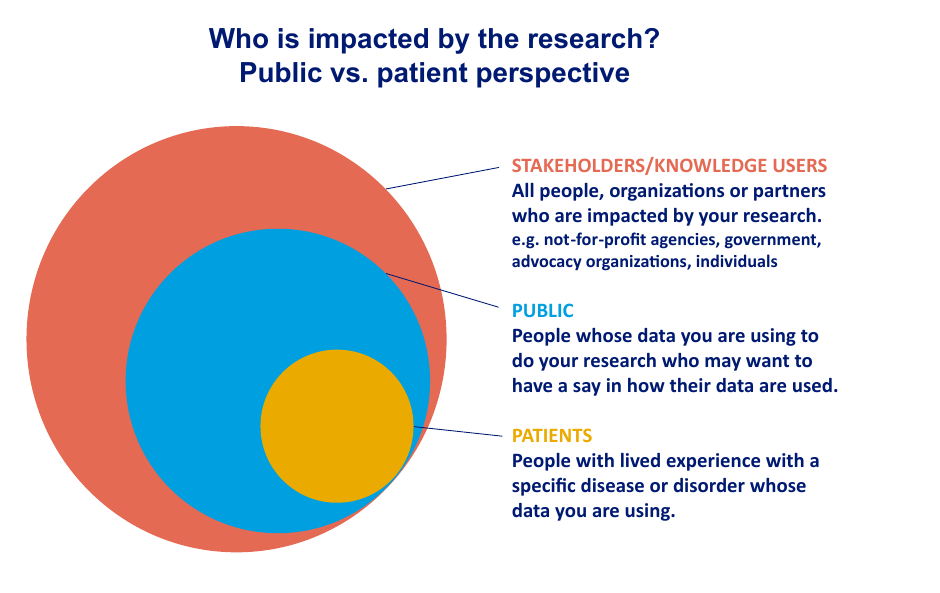
Figure 3: Levels of perspective, describing ICES’ approach to defining the difference between stakeholder, public and